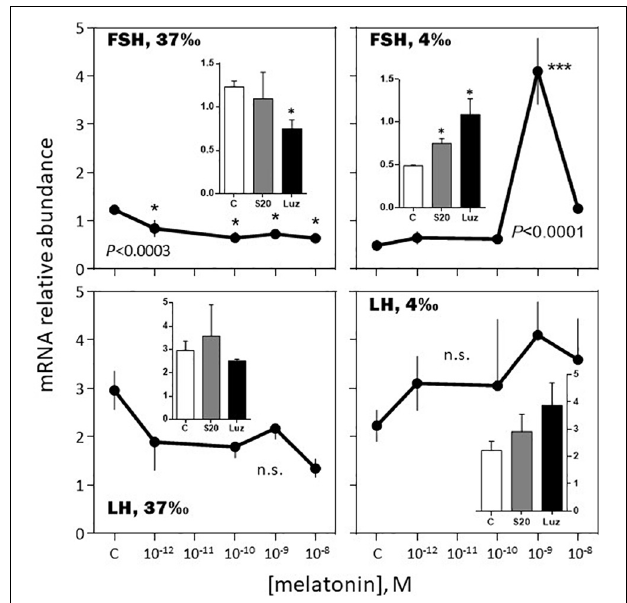
FIGURE 8 | Effects of melatonin and melatonin analogs on FSH and LH mRNA relative abundance in vitro . Mean ± S.E.M. of n = 3 pools (containing 5 glands each). One-Way ANOVA ( P gives the level of significance; n.s.: non-significant). Means were compared to the corresponding control using the Holm-Sidak’s post hoc test: * P < 0.05, *** P < 0.0005. The insets show the 12 h effects of two melatonin analogs S20304 (S20 at 10 – 8 M) and luzindole (Luz at 10 – 7 M). Mean ± S.E.M. of n = 3 pools (containing 5 glands each). Values are compared to the controls using the Student’s t -test at P < 0.01. See Figure 6 for more